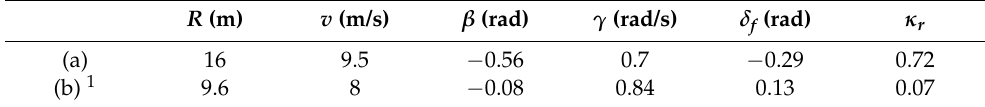
Table 2. The vehicle main status parameters in drift motions based on the steady-state analysis.